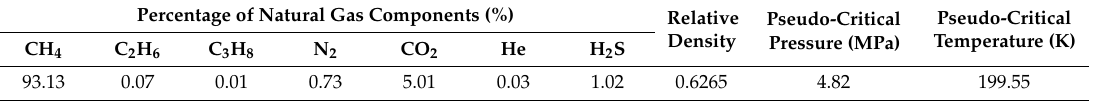
Table 2. Composition and properties of experimental natural